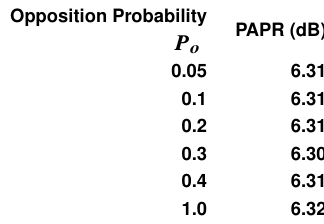
Table 1. Comparison of computational complexity for CCDF D 10 (cid:0) 3 among different opposition probability values. The smaller value is in bold